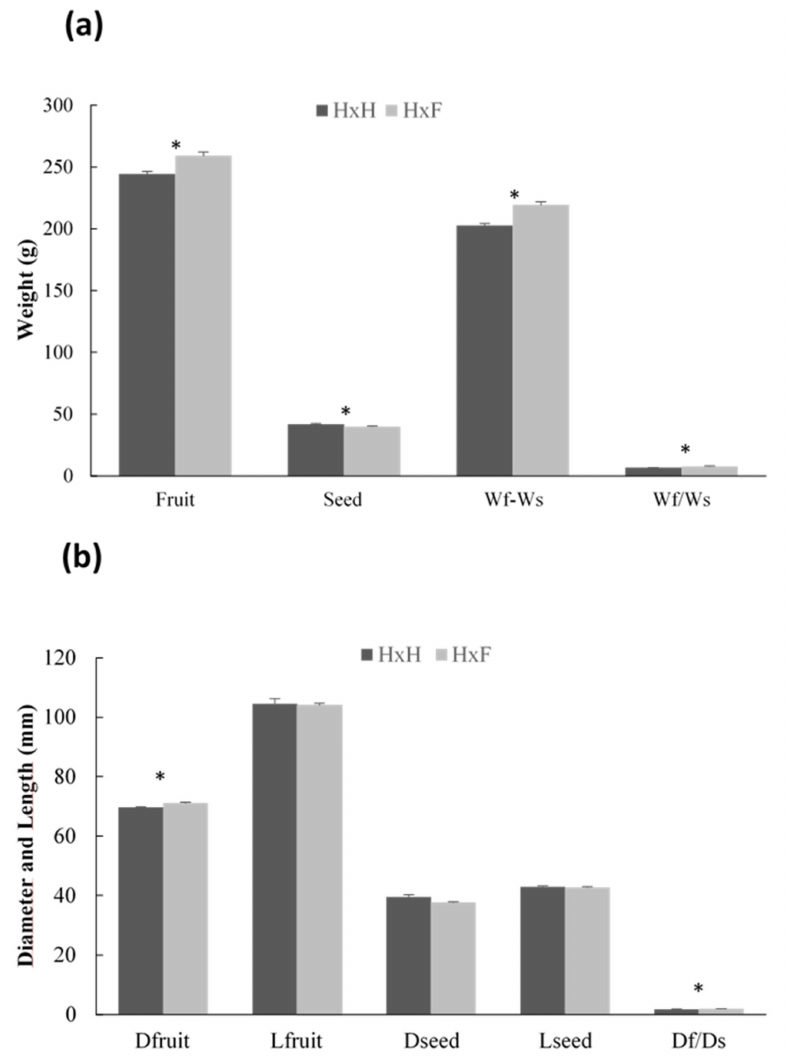
Figure 9. Fruit and seed characteristics in selfed and outcrossed ‘Hass’ avocado fruits. ( a ) Mean of fruit and seed weight (g), pericarp weight (g) defined as the difference in fruit and seed weight (Wf-Ws) and fruit: seed weight ratio (Wf/Ws). ( b ) Mean of diameter and length of fruits (mm) and seed (mm) as well as the ratio between fruit diameter and seed diameter (Df/Dd). The asterisks show significant differences in these parameters between selfed (Hass × Hass) and outcrossed (Hass × Fuerte) fruits at p < 0.05 (Student’s t